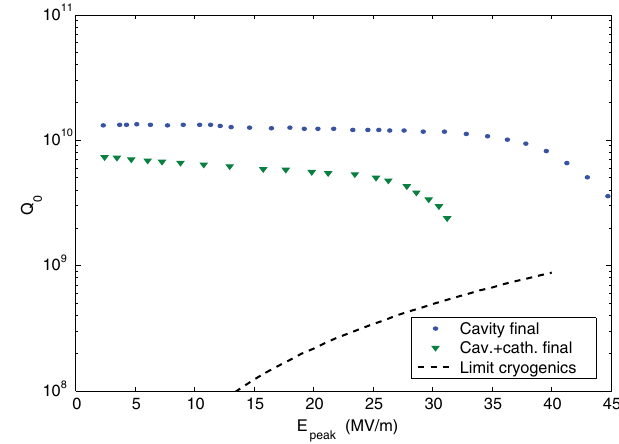
FIG. 8. Q 0 vs E measurements of the 704 MHz half cell BNL gun cavity without cathode stalk. Courtesy of Ilan Ben-Zvi, BNL.